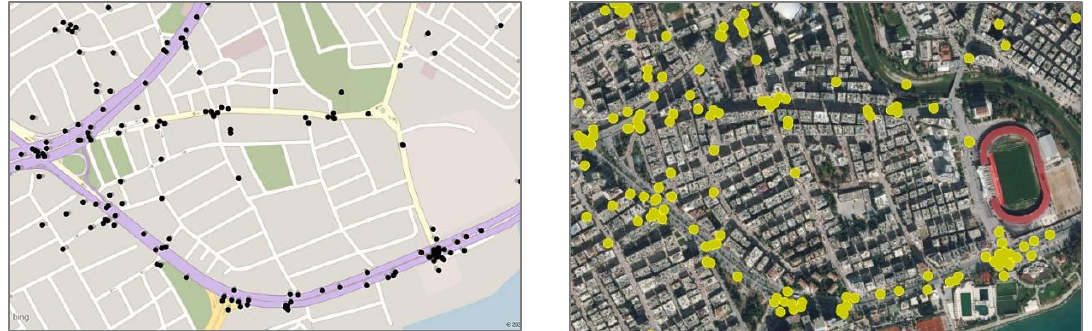
Figure 11 Street Network and Location of Accidents in Pirireis